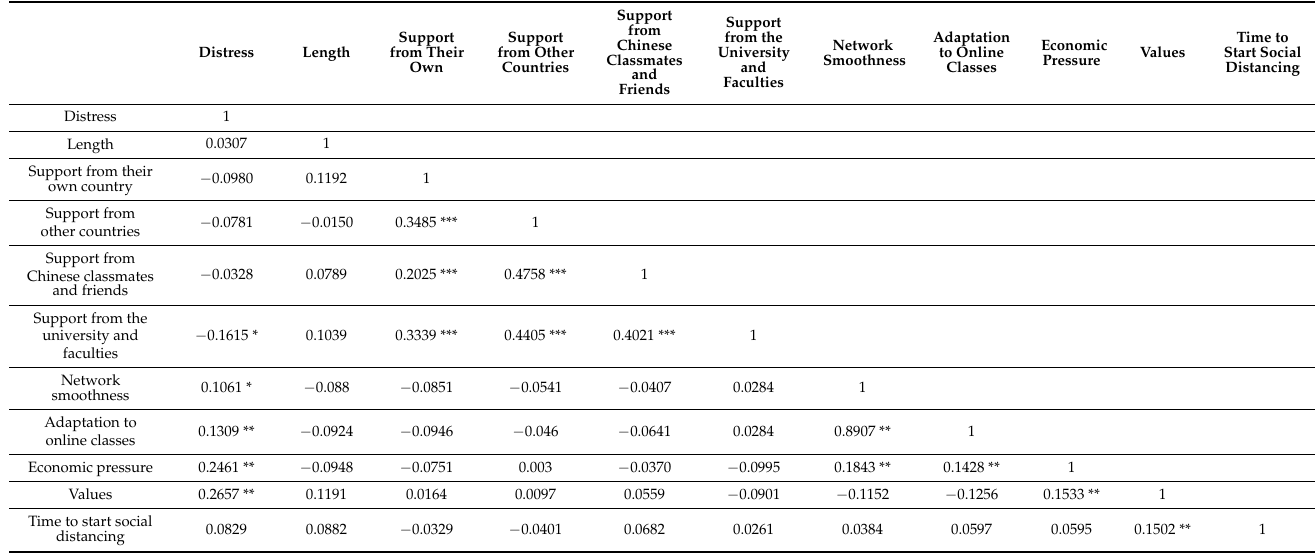
Table 2. Correlation